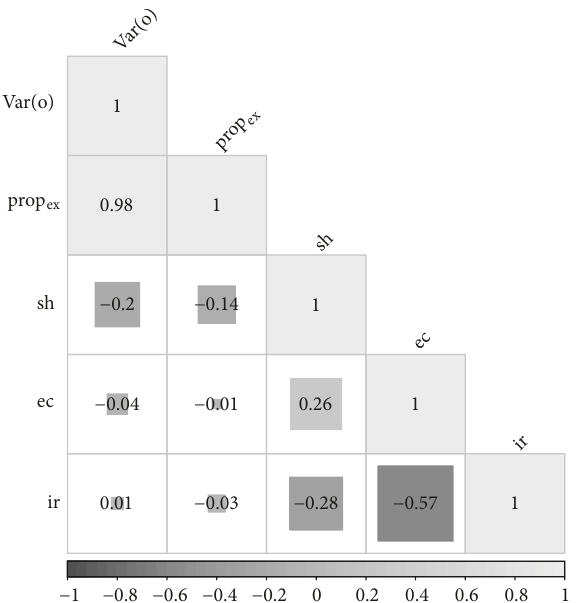
Figure 8: Significant correlation estimates for the metrics of interest in the mixed opinion dyamics